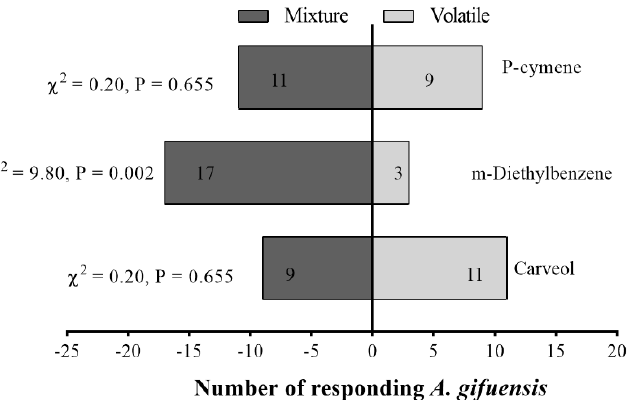
Figure 7. Behavioral responses of Aphidius gifuensis female adults (n = 20) to 10 μ L of synthetic chemicals at different concentrations (0.01–10 μ g/ μ L) in olfactometer bioassays: ( a ) p-Cymene, ( b ) Carveol, ( c ) m-Diethylbenzenel.